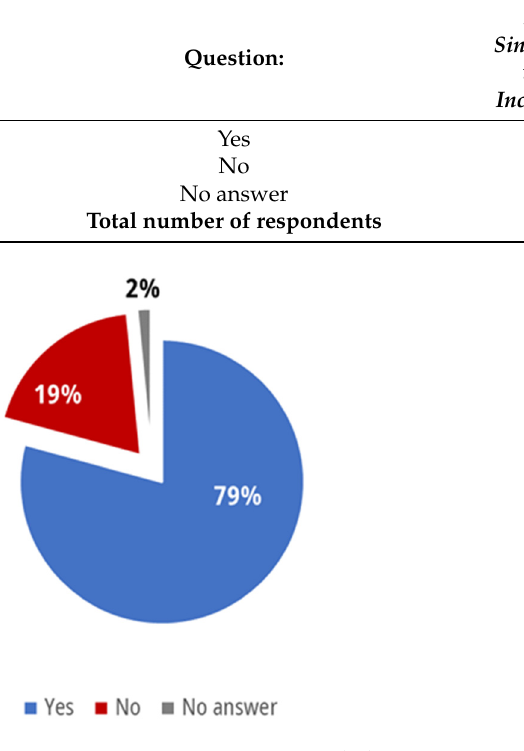
Figure A13. Responses to question (18).